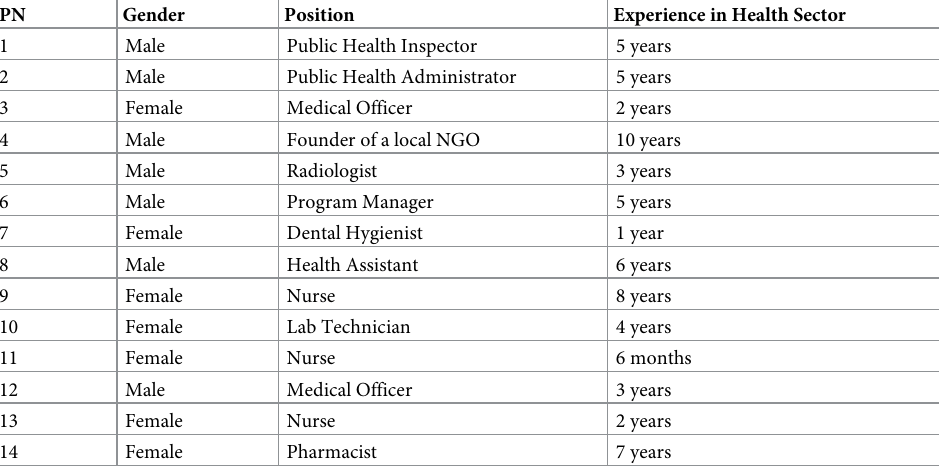
Table 2. Characteristics of participants involved in in-depth interview (n =